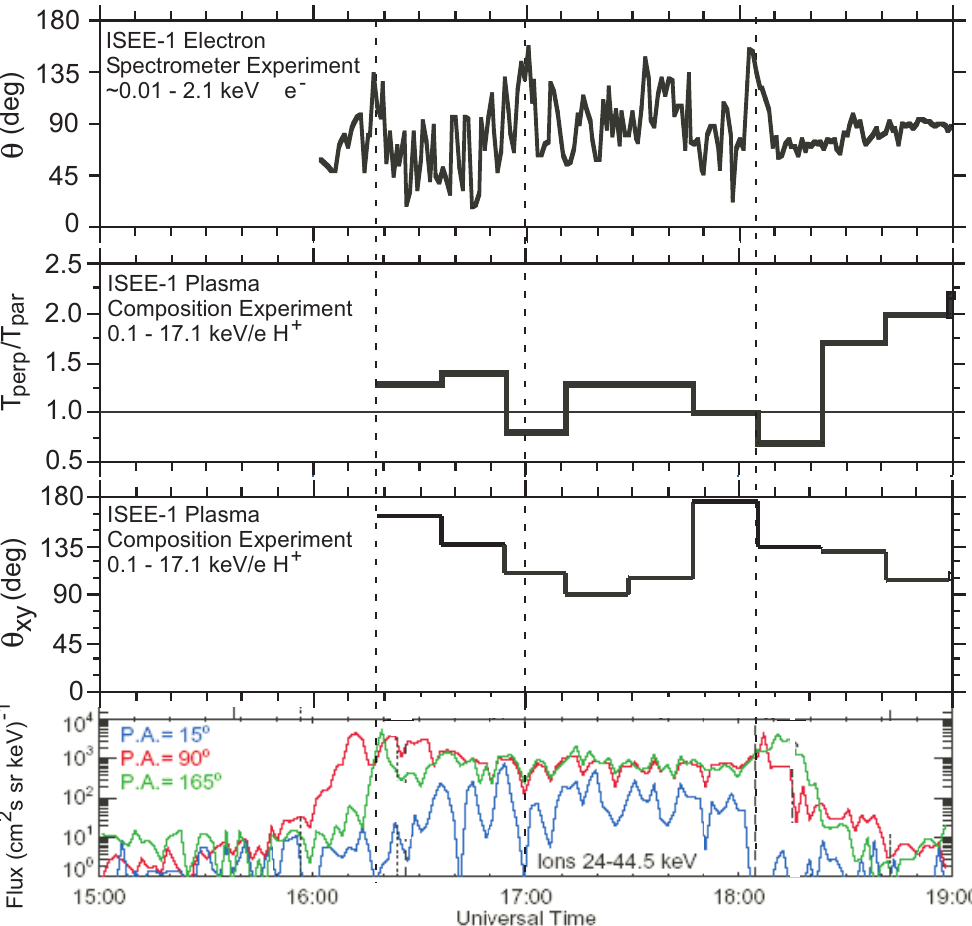
Fig. 2. Top to bottom, Angle between the electron bulk flow direction and the magnetic field, ratio of perpendicular and parallel temperatures for H + (from 0.1–17.1keV/e), angle between the H + flow in the ecliptic plane and the ecliptic plane magnetic field, and energetic (24– 44.5keV) ion fluxes at three pitch angles. Dashed lines show three times when the energetic ion flux anti-parallel to the magnetic field is much larger than the parallel flux and the corresponding electron flows are directed nearly anti-parallel to the magnetic field. At the exit from the cusp (starting at 17:50UT), energetic ion fluxes perpendicular to the magnetic field are less than those along the field and the thermal ion population shows an anisotropy T ⊥ /T || < 1. Later, energetic ion fluxes perpendicular to the magnetic field are greater than those along the field and the thermal ion population shows an anisotropy T ⊥ /T || > 1. These comparisons demonstrate that the energetic ion population is simply part of an anisotropic thermal population that is convecting poleward and